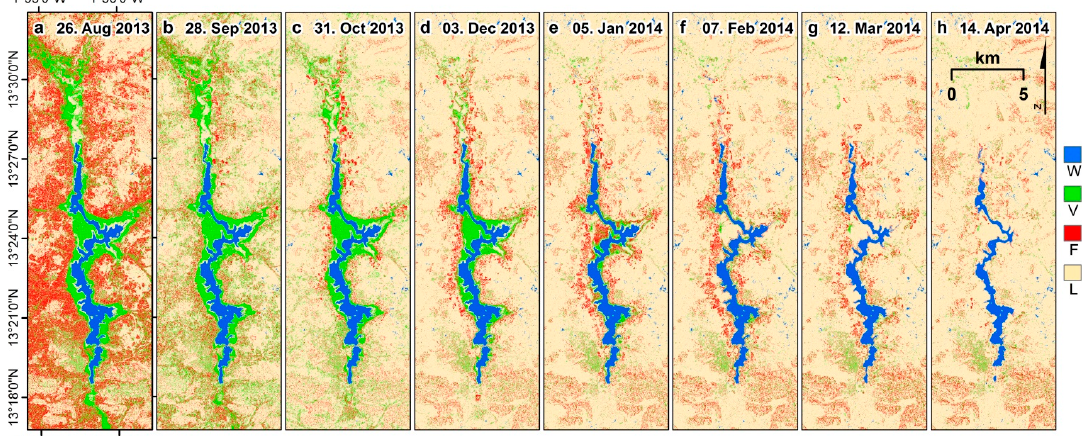
Figure 9. Monotemporal classification for eight selected time steps with intervals of 33 days between the data: open water (blue); flooded/floating vegetation (green); irrigated fields (red); and dry land (beige) for ( a ) 26 August 2013; ( b ) 28 September 2013; ( c ) 31 October 2013; ( d ) 3 December 2013; as well as ( e ) 5 January 2014; ( f ) 7 February 2014; ( g ) 12 March 2014; and ( h ) 14 April 2014.